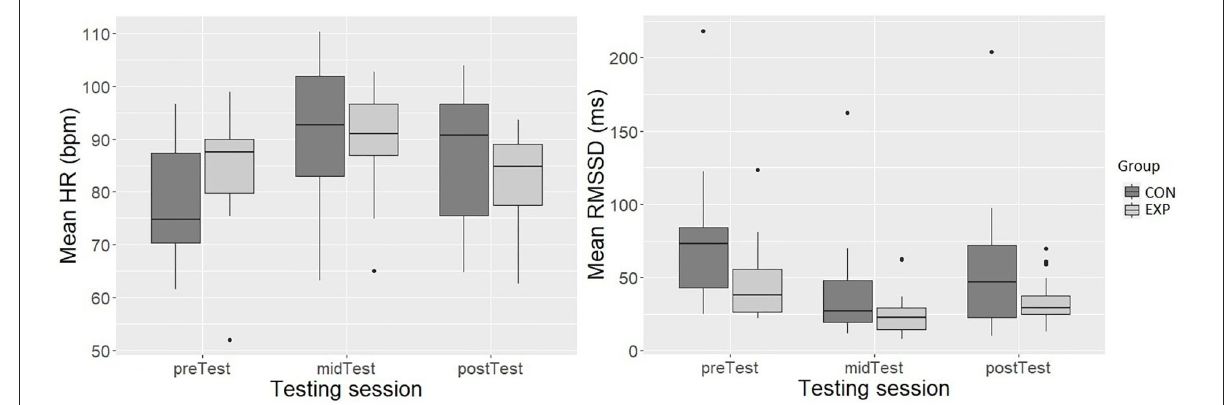
FIGURE5 The mean HR (bpm) (y-axis; left-side graph) and the mean RMSSD (ms) (y-axis; right-side graph) during the SART testing sessions (x-axis; both graphs). The box depicts 50 % of all values (IQR). The top 25% and bottom 25% of all values are excluded from the box. The top and bottom of the whiskers are the minimum and maximum, excluding outliers (outliers defined 1.5 x IQR). The horizontal line inside the box represents the median